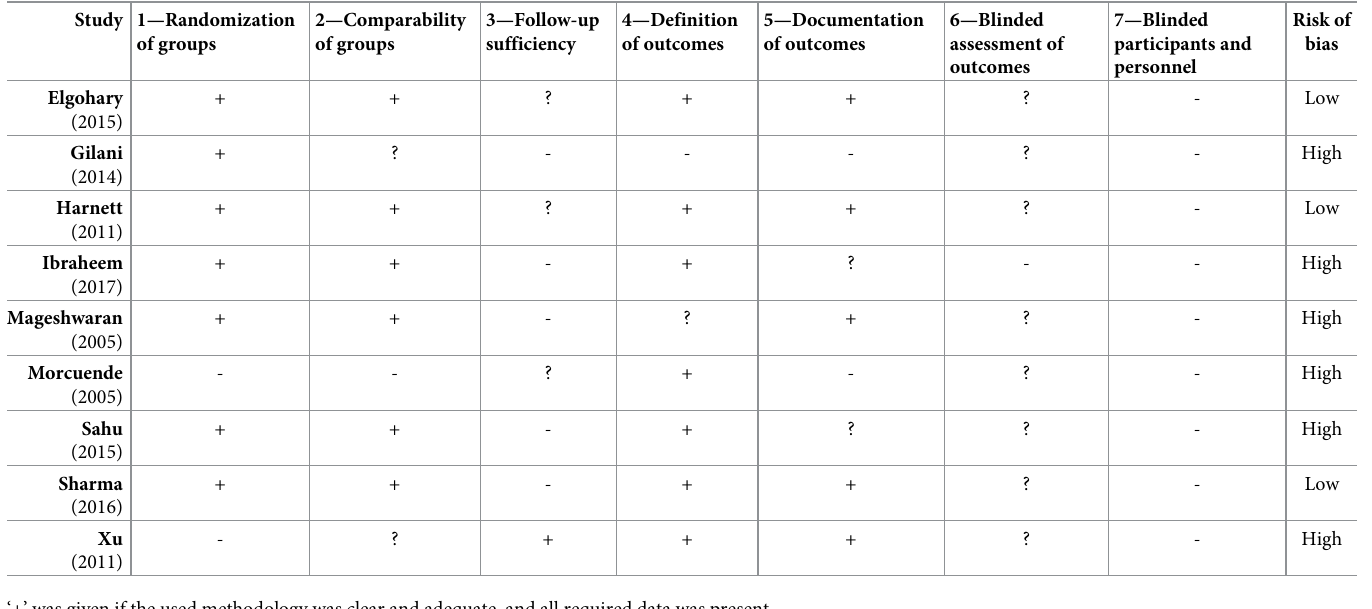
Table 3. Risk of bias